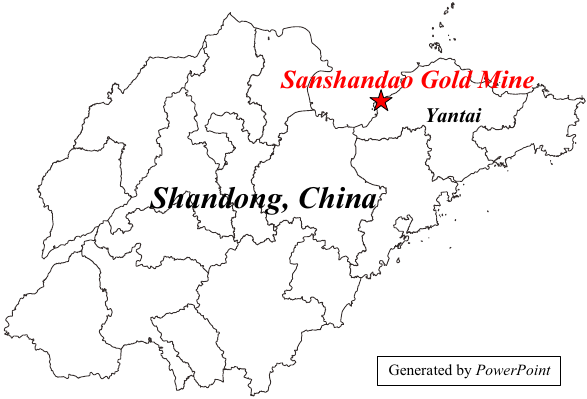
Figure 19. The location of Sanshandao Gold Mine.